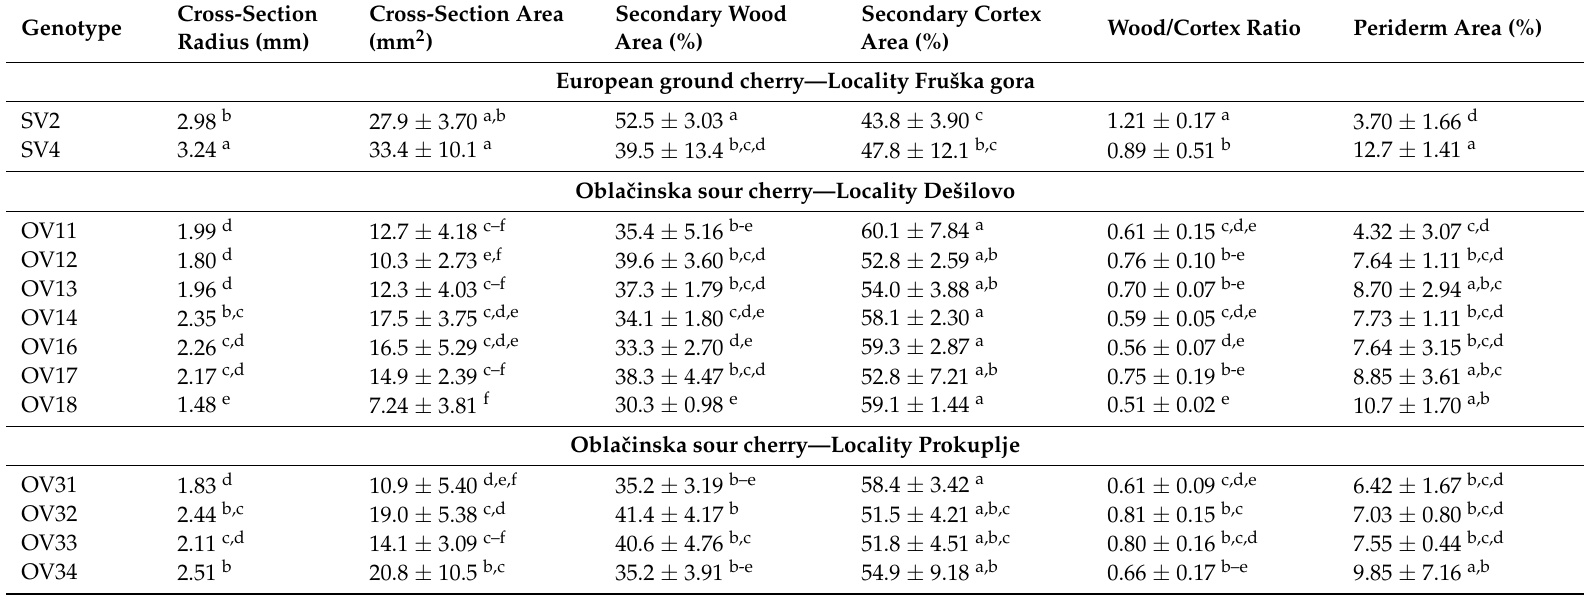
Table 2. Anatomical characteristics of roots with secondary